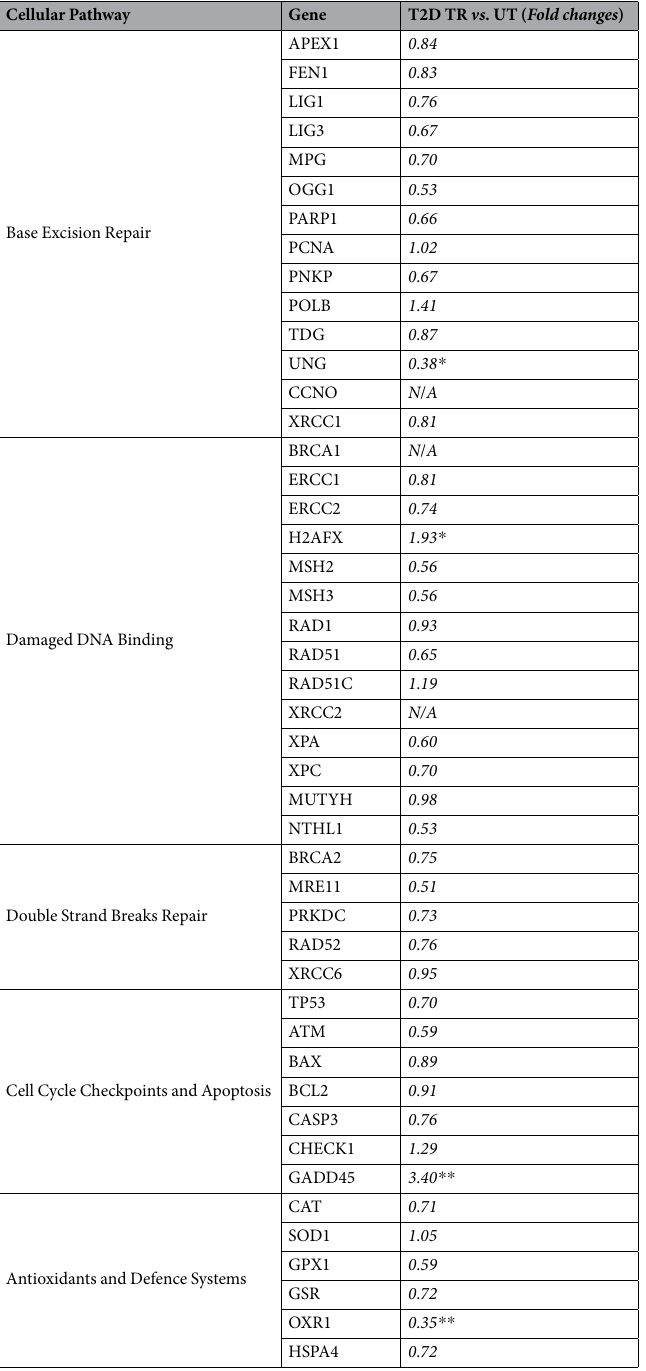
Table 2. Gene expression analysis in human leukocytes. Calculated fold changes of 46 PCR gene products derived from RT-qPCR-array. * p < 0.05, ** p < 0.01. T2D , Type 2 Diabetes; UT , untrained; TR , trained; N/A , not